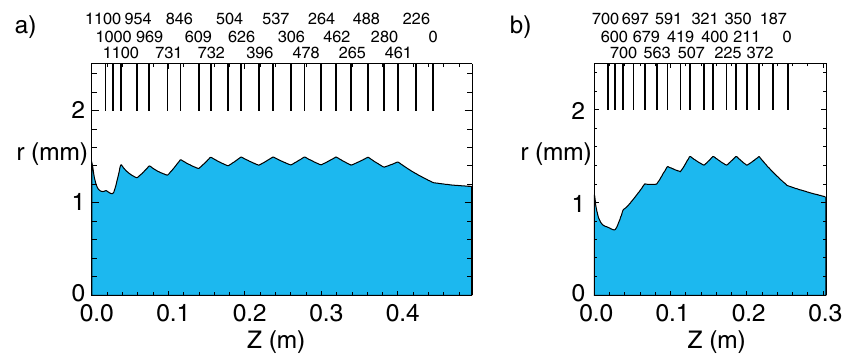
FIG. 10. (Color) Example layout of the aperture plates with the beam envelope. (a) Merging at 1.2 MeV for a case with 91 beamlets. (b) Merging at 0.8 MeV for a case with 169 beamlets. Both cases are well optimized. The voltages of the plates are given in